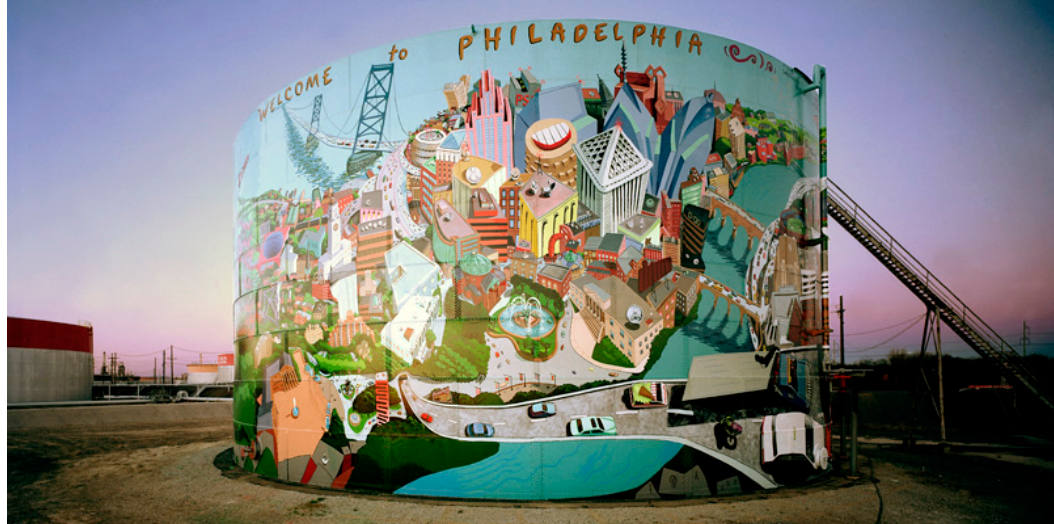
Figure 4. Image of the wall made by Paul Santoleri representing “the frenzy and vivacity of the city of Philadelphia” on the side of a refinery